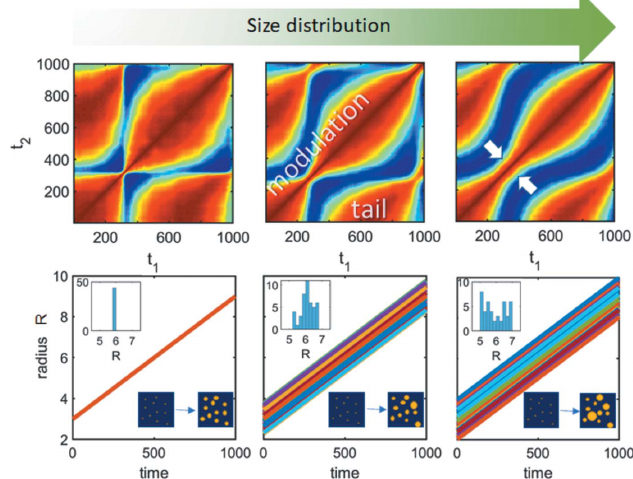
Figure 3 Particle-based simulation of linear growth with different radii distribu- tions. The bottom row demonstrates the evolution of the radii of particles with time, with the real-space schemes in the right-bottom insets and the distribution of radii in the left-upper insets. Different colors correspond to different particles. The upper row of the figure shows the corresponding calculated TTCs at the same q value. White arrows point to the modulation waist in the TTC. The size distribution increases from the left to the right with the same behavior of the mean value.